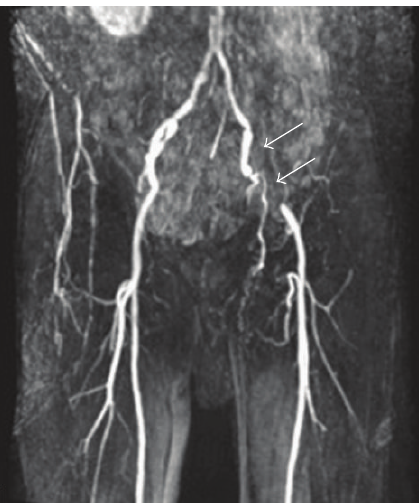
Figure 1: MIP (Maximum Intensity Projection) image from Mag- netic Resonance Angiography (MRA) examination demonstrating occlusion of the left external iliac artery (arrows). The left common iliac artery, internal iliac artery, and common femoral artery remain